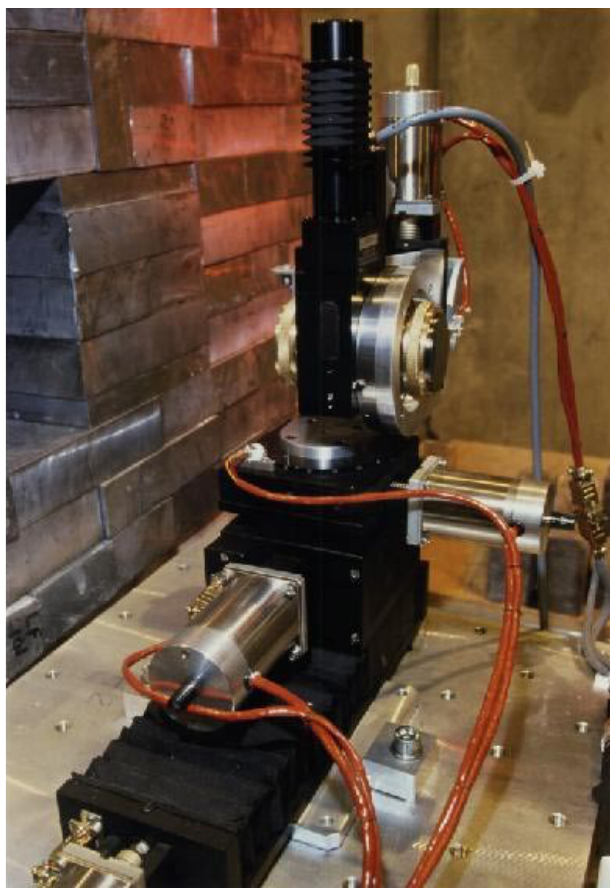
FIG. 10. (Color) Birefringent (quarter wave plate) Si crystal and